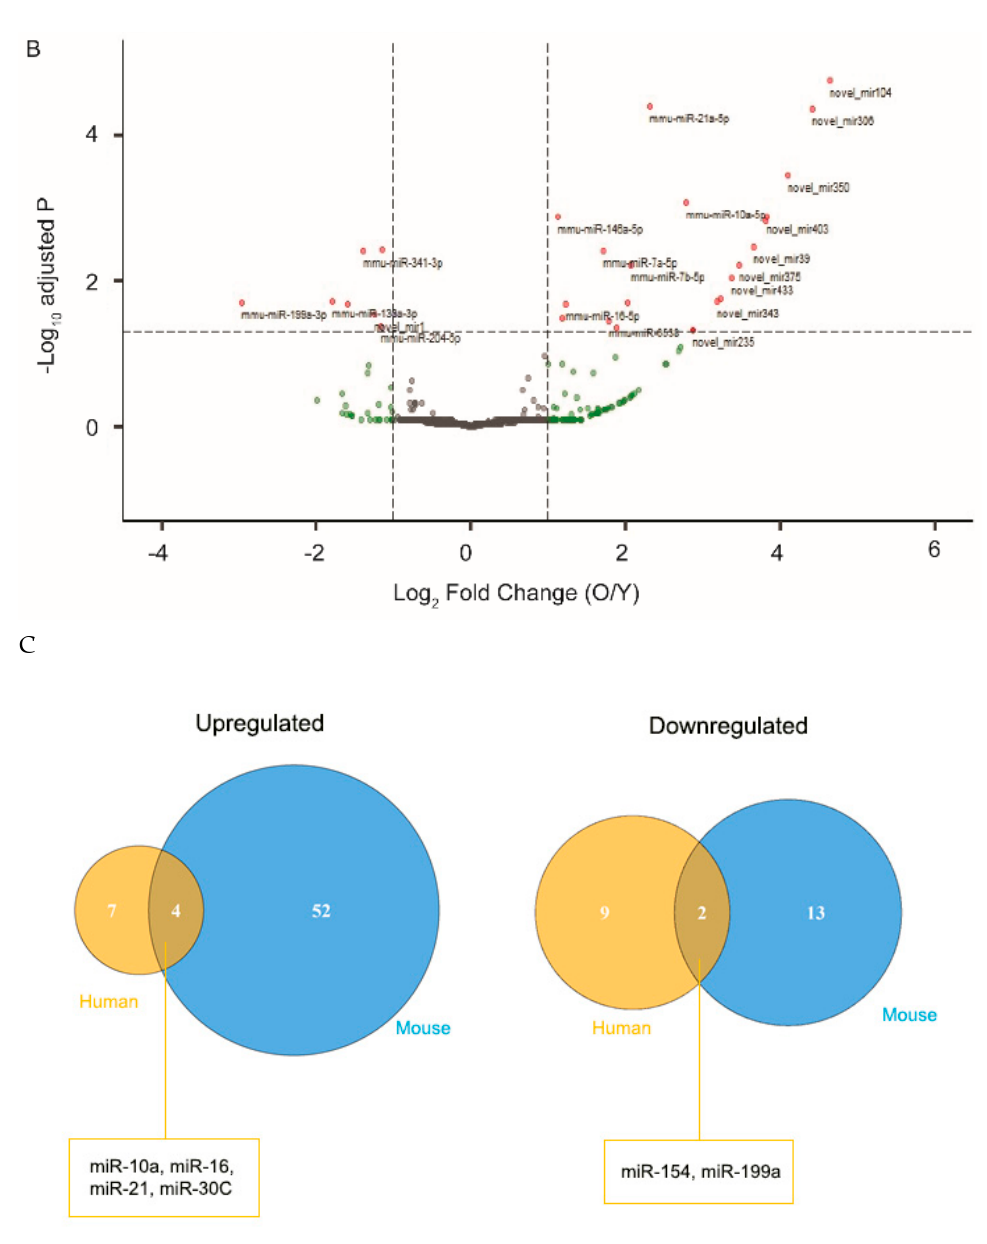
Figure 1. Di ff erential expression of miRNAs in extracellular vesicles (EVs) from young and old retinal pigment epithelium (RPE). EVs were isolated from either cultured human RPE cells ( A ) or mouse RPE / choroid-conditioned medium ( B ). EV-associated RNA was extracted and sequenced. Di ff erential gene expression data were presented as volcano plots to show the fold of change ( x -axis) and adjusted p value ( y -axis). The horizontal dashed line indicates an adjusted p -value < 0.05 threshold, and vertical dashed lines indicate a fold change > 2 threshold. MiRNA species showing significant changes in EVs derived from aged RPE were marked with red and annotated on the plots. ( C ) Venn diagrams illustrating the number of exosomal miRNAs with significantly altered expression between young and aged samples from human or mouse RPEs. Mature sequences of the miRNA species at the intersections are conserved between mouse and human.